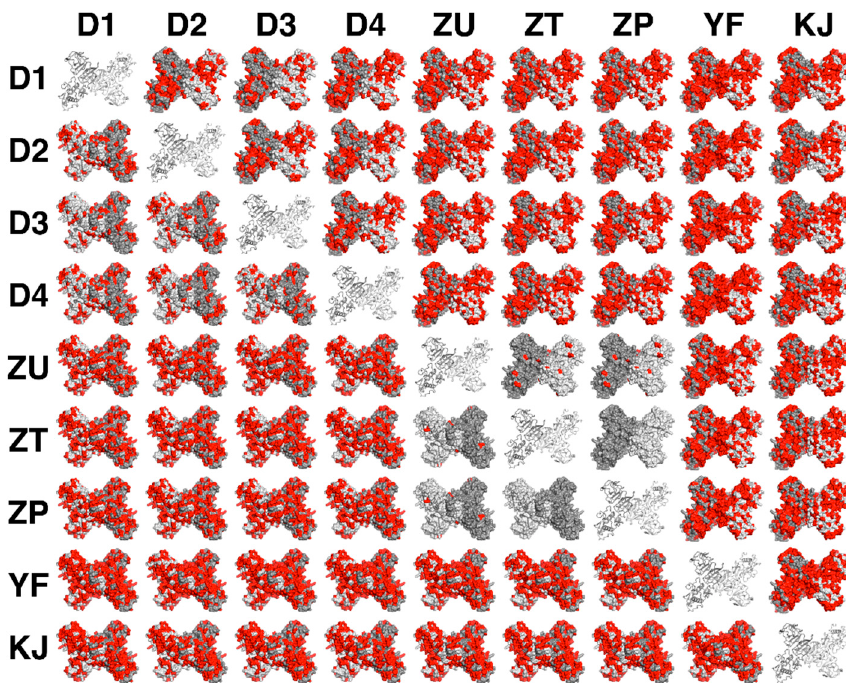
Figure 2. Pairwise di ff erences visualised for the NS1 dimer. Sequences of DENV-1–4 (D1–D4); ZIKV Uganda strain (ZU), ZIKV Thailand strain (ZT) and ZIKV Puerto Rico strain (ZP); YFV (YF) and KUNV (KJ) were aligned using MAFFT [19]. The di ff erences between all pairs were identified and mapped onto the recent high-resolution X-ray structure of the ZIKV NS1 dimer 5K6K [20]. Dimers are shown in surface representations with the monomers shown in light grey and dark grey, respectively. The di ff erences between each pair are shown in red. The upper left and lower right triangular sections show a top and bottom view of the protein, respectively. The diagonal elements show the NS1 structure in cartoon representation. Images were generated using PyMol